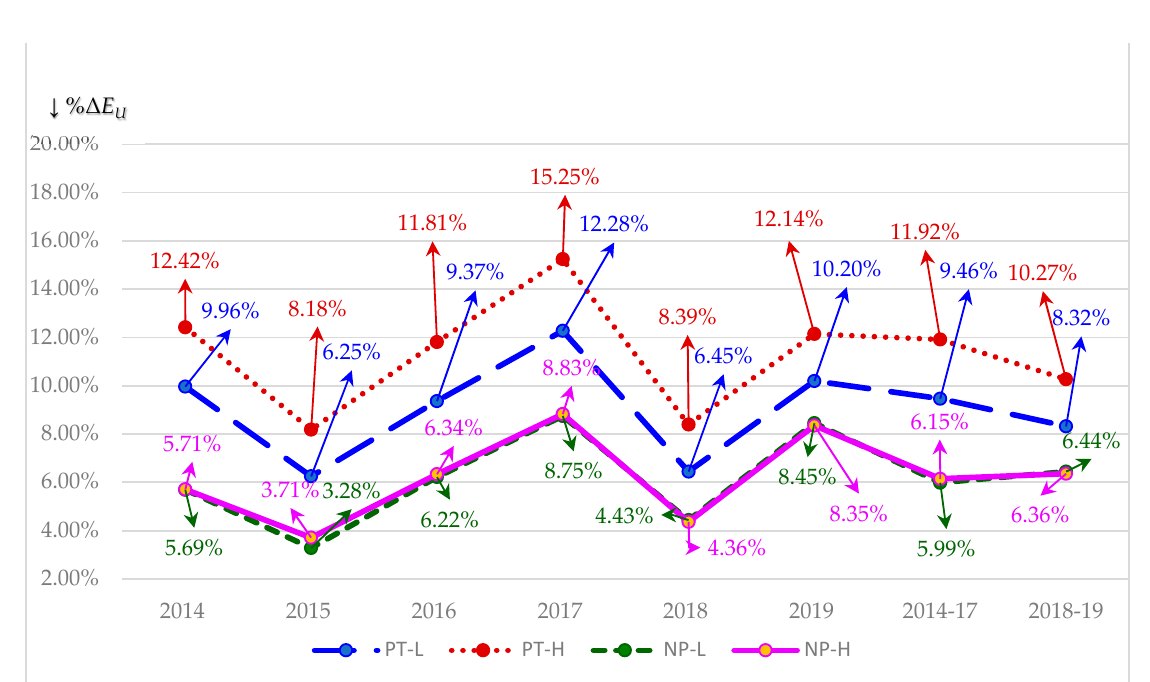
Figure 10. Percent change in unlevered equity (% Δ E U ) values are plotted along the vertical axis against six years (where annual credit spreads are different) and two periods (where annual credit spreads are averaged) along the horizontal axis. The four trajectories are NP- L trajectory, solid line; NP- H trajectory, small dashed line; PT- L trajectory, large dashed line; and, PT- H trajectory, dotted line. We use pre-TCJA tax rates for 2014–17 with 3.12% growth rate and TCJA tax rates for 2018–2019 with 3.90% growth rate. Both the low ( L ) and high ( H ) tax rates are used where the growth ( RE ) constraint sets in after Ba1 for nonprofits (NPs) and after Ba2 for pass-throughs (PTs). As seen in Table 6, the optimal credit rating ( OCR ) varies over time with an OCR of A3 for the last two years of 2018 and 2019 for both NPs and PTs.